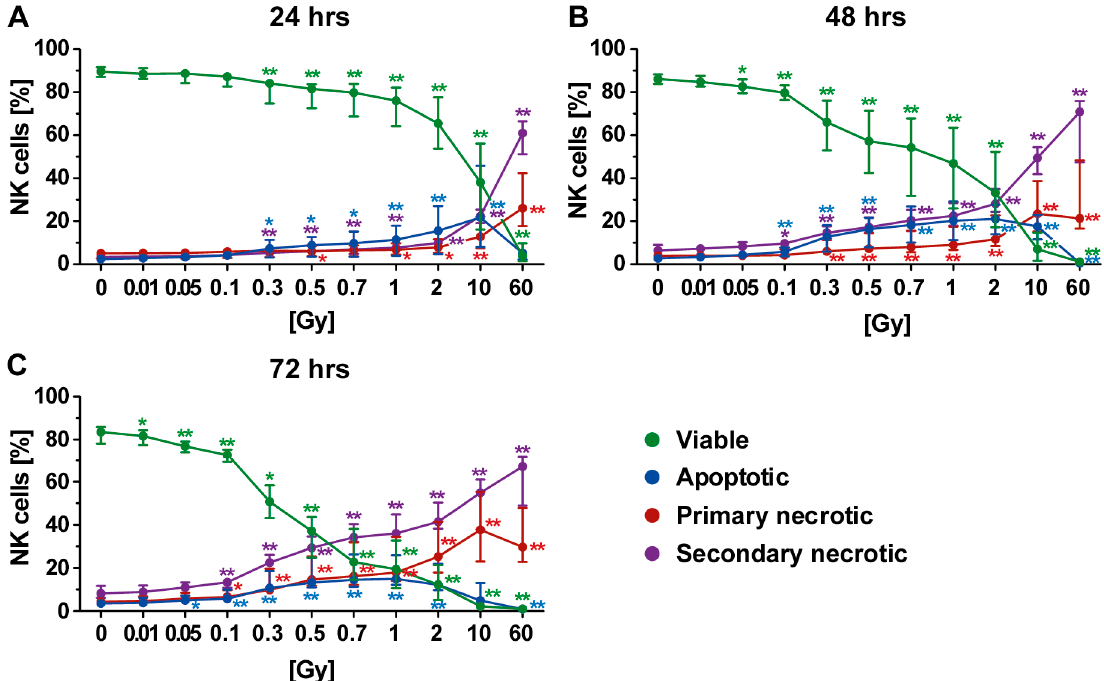
Figure 5. Forms of cell death in NK cells at different time points after irradiation. ( A – C ) NK cells were the most radiosensitive cells of all investigated human immune cells of the peripheral blood. The viability (green) already decreased after exposure to very low single dose of radiation. The most prominent type of cell death was secondary necrosis (violet), except at the early time point (24 h after radiation exposure) at which apoptosis (blue) had a higher impact. The colored dots represent the percentage distribution of viable (green), apoptotic (blue), primary (red), or secondary necrotic (violet) NK cells as determined by AxPI staining and flow cytometry at ( A ) 24, ( B ) 48, or ( C ) 72 h after irradiation. Each data point represents the median (±IQR) from eight independent experiments from four different donors. Data points have been connected by lines to improve visual clarity. Statistical analyses were performed against the corresponding nonirradiated control (0 Gy) using the Mann–Whitney U test (*: p < 0.05; **: p < 0.01).